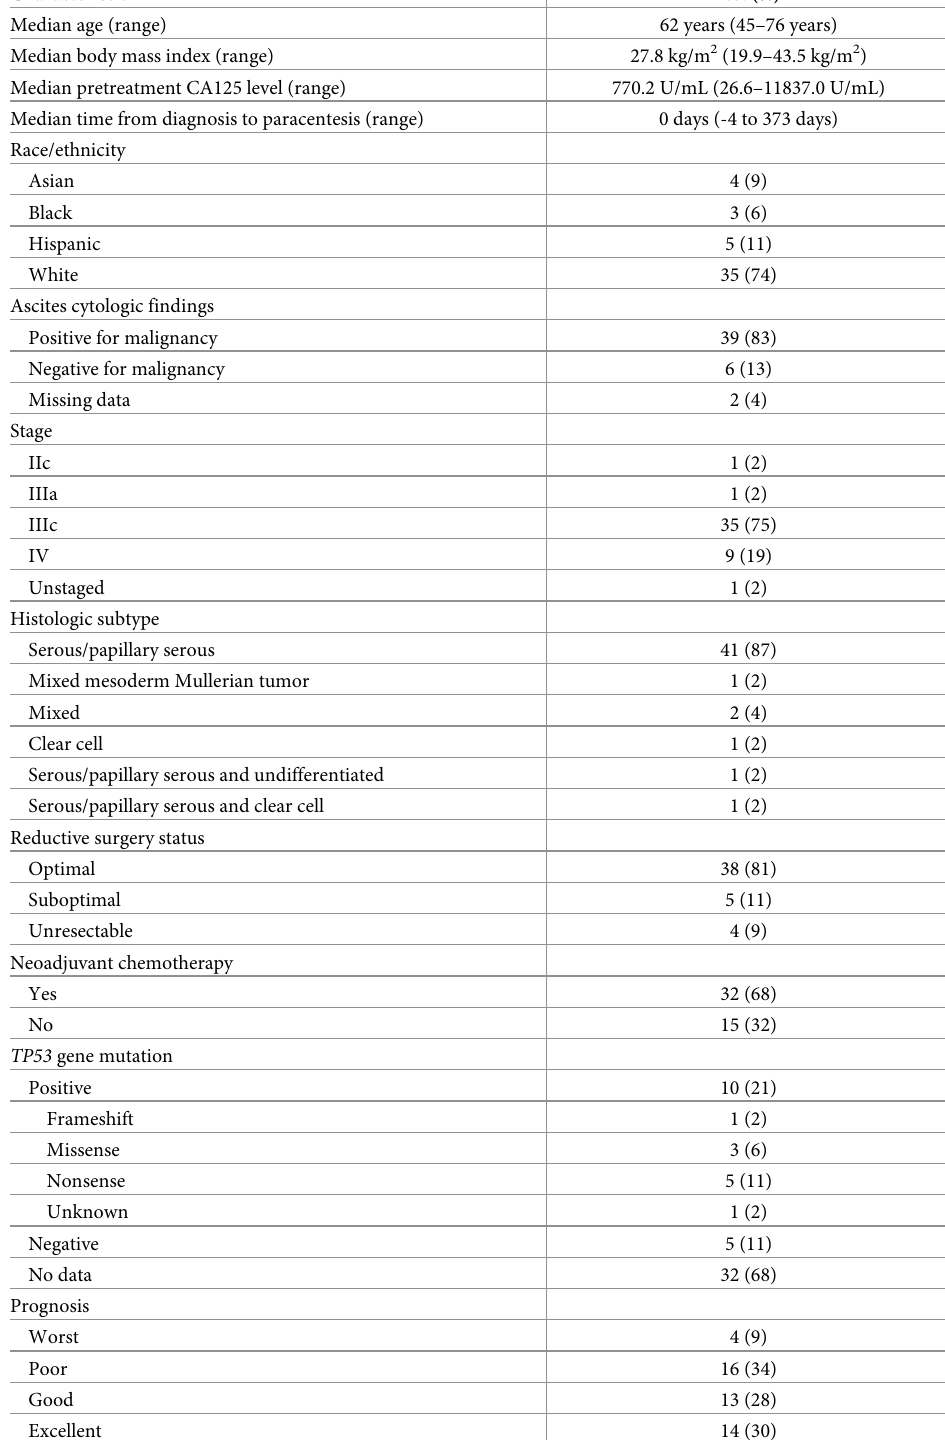
Table 1. Clinical characteristics of the study cohort (n =